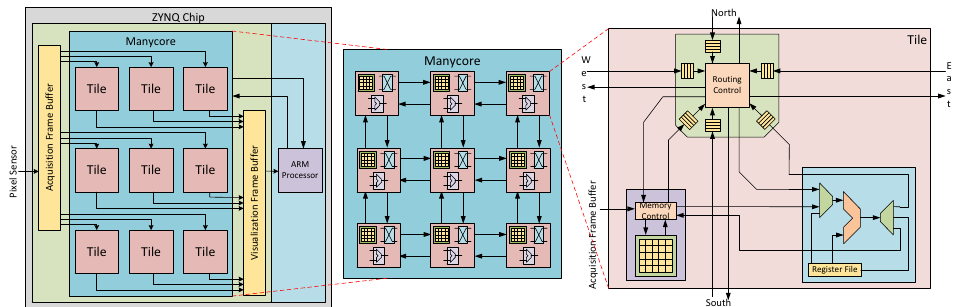
Figure 4. The manycore hardware architecture designed in our work.